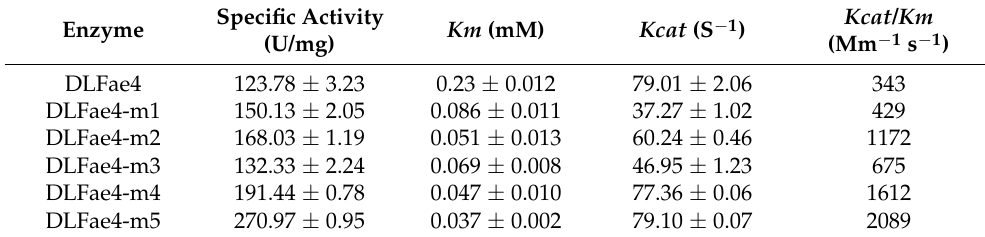
Table 1. Kinetic parameters of DLFae4 and variant on MFA.